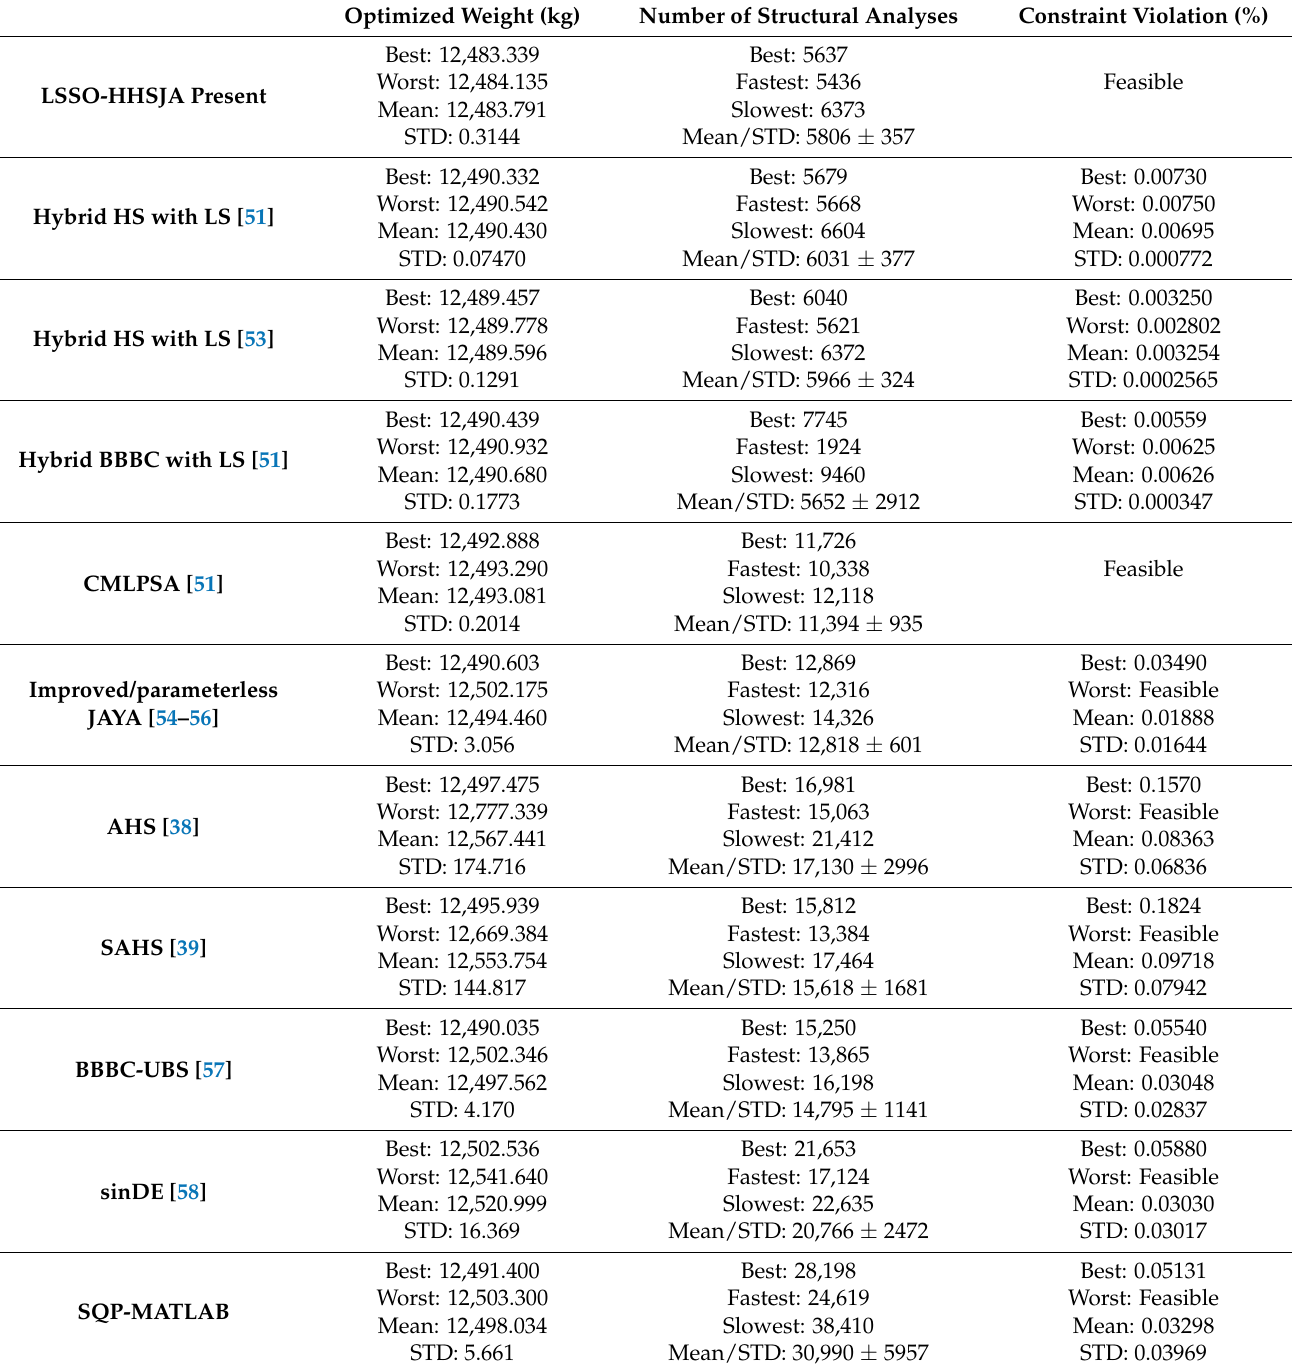
Table 2. Optimization results obtained for the 200-bar truss design example. Optimized Weight (kg) Number of Structural